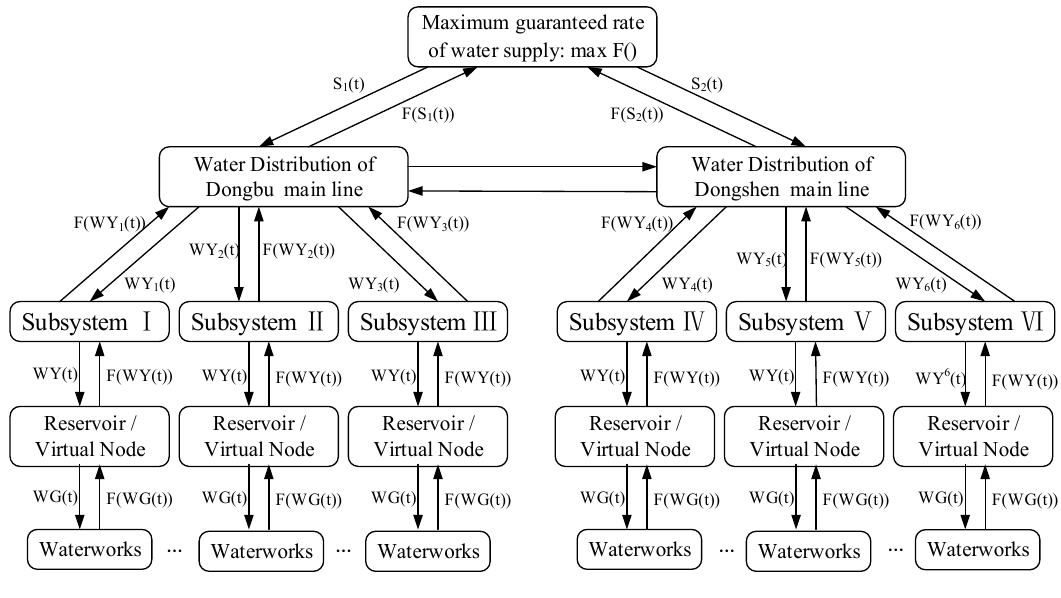
Figure 5. The hierarchical structure of the large-scale system decomposition model.